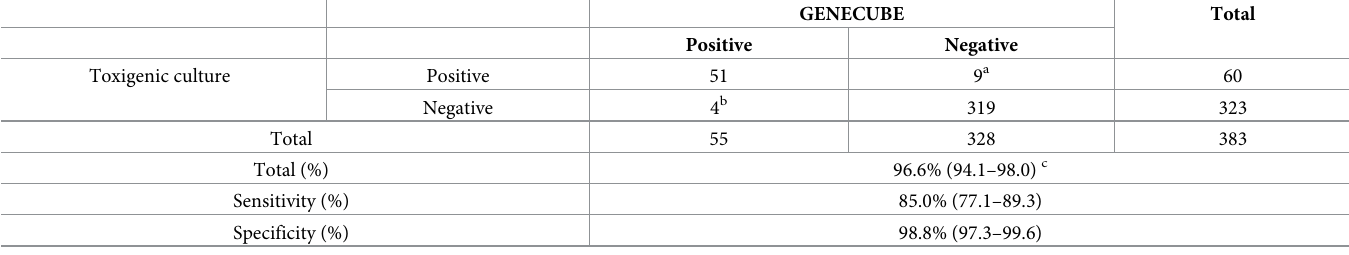
Table 4. Comparison of the GENECUBE Clostridioides difficile assay with toxigenic